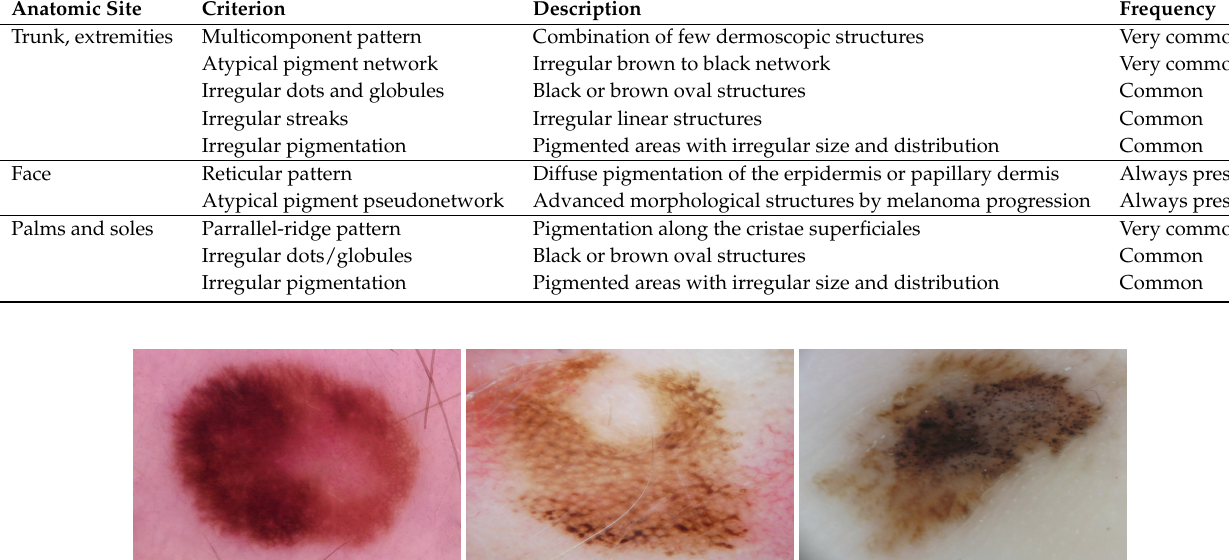
Figure 1. Dermoscopic images of in situ or early invasive melanomas presenting different dermoscopic features according to the anatomic site: ( left ) melanoma on the leg characterized by an atypical pigment network and irregular streaks, ( middle ) melanoma on the face characterized by reticular pattern, and ( right ) acral melanoma characterized by parallel- ridge pattern and irregular